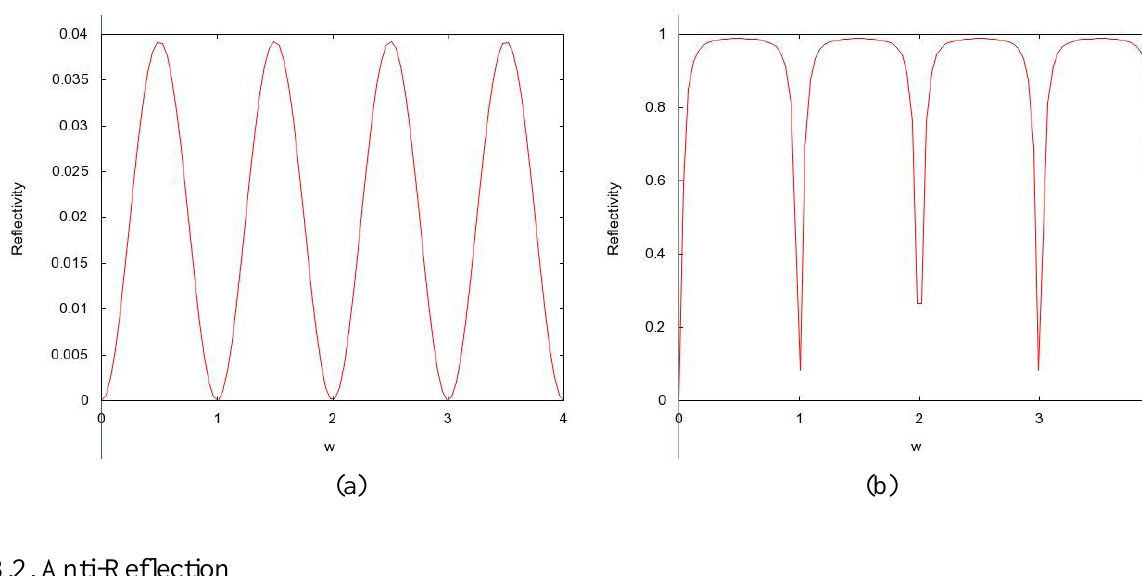
Figure 6. Reflectivity ℛ 𝜔 (a) and R